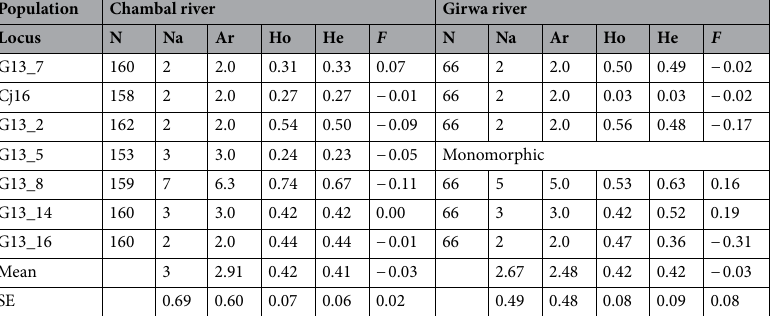
Table 1. Genetic diversity of 228 individuals at seven microsatellite nuclear loci. Number of individuals sampled (N), number of alleles per locus (Na), standardised number of alleles (Ar), observed heterozygosity (Ho), expected heterozygosity (He), Inbreeding coefficient ( F ).